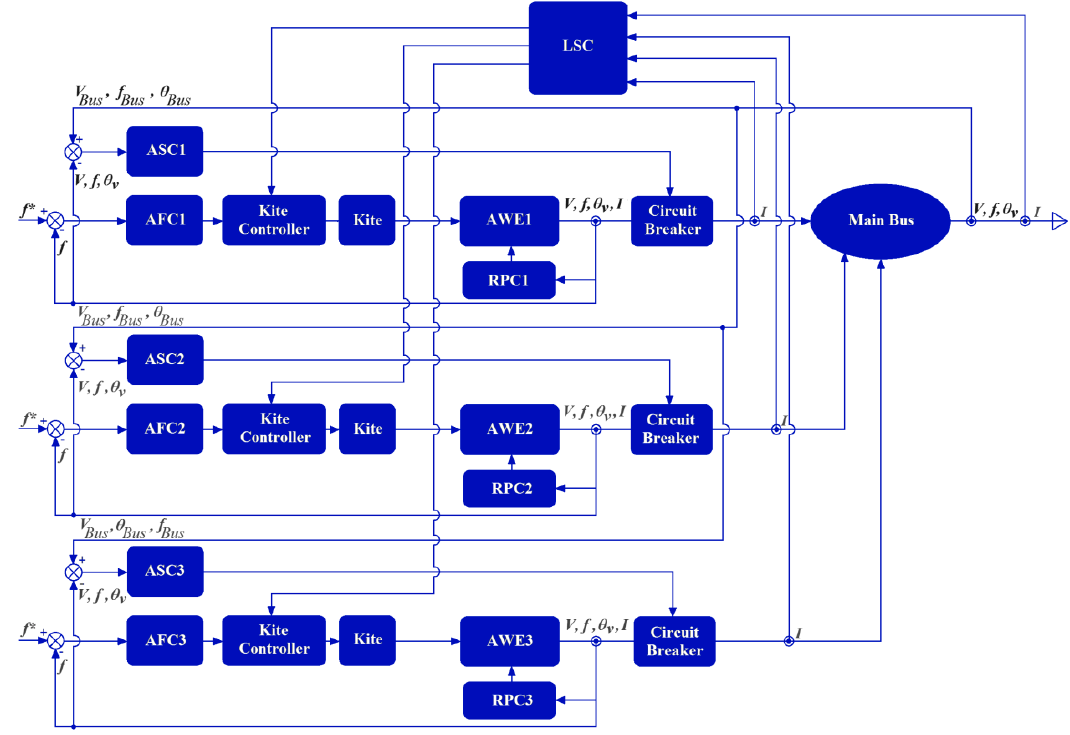
Figure 10. AWE farm control diagram.